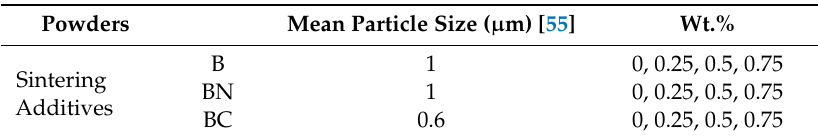
Table 10. List of sintering additives, their particle size, and wt.%. Boron (B), boron carbide (BC), and boron nitride